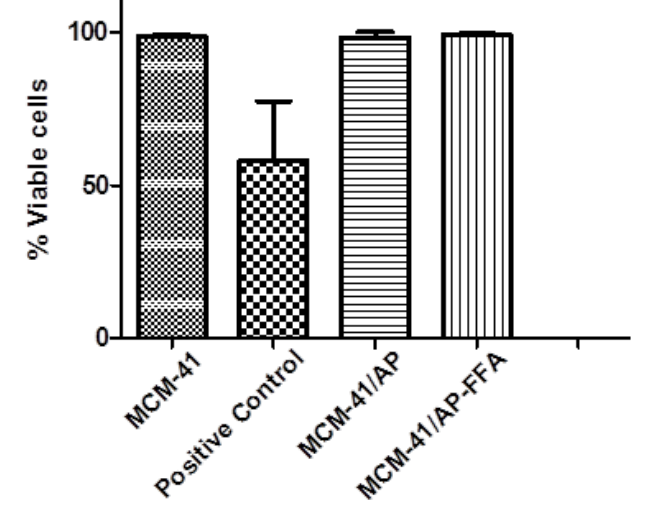
Figure 10. Biocompatibility graph for MRC-5 cells treated with MCM-41, MCM-41/AP, and MCM-41/AP-FFA.